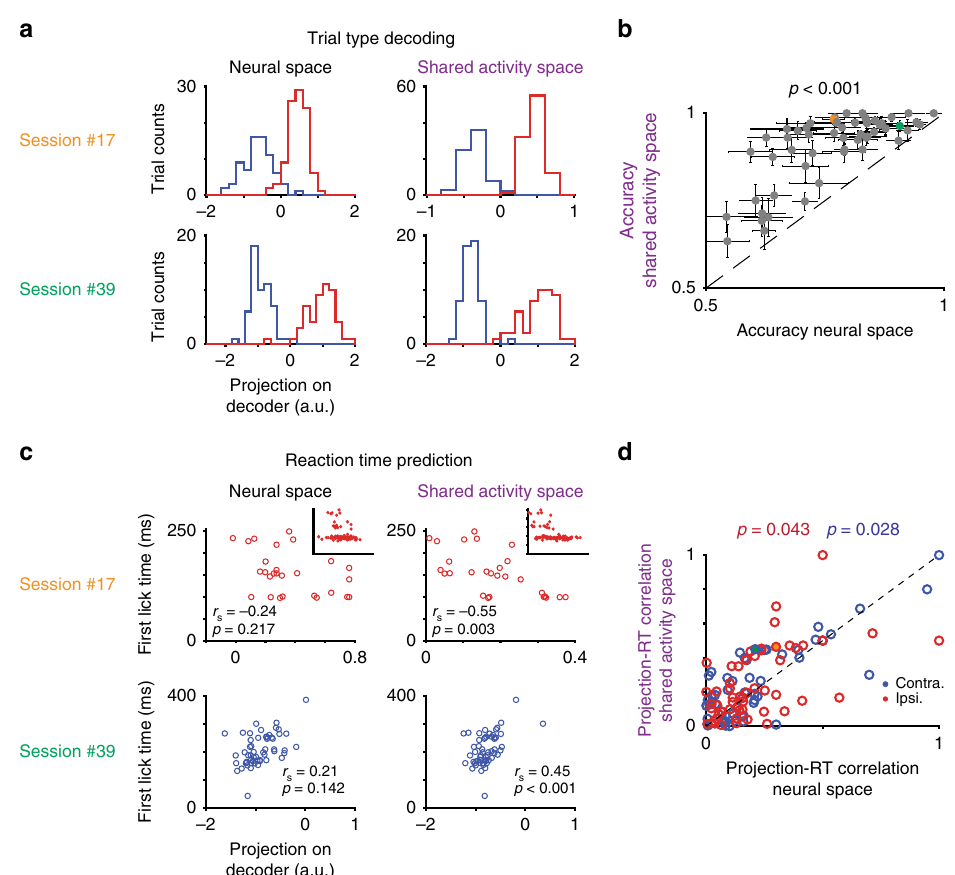
Fig. 3 Neural dynamics in shared activity space correlates with trial-by-trial variability in behavioral reaction time and performance on single trials. a Histograms of projection of all correct trials on decoder separately for each trial type (ipsi trials red, contra trials blue), for full neural space (left) and shared activity space (right). Session #17, upper; Session #39, lower. b Accuracy of decoders based on full neural space (x-axis) and shared neural space ( y -axis) across all sessions. Each circle represents a recording session. Error bar, std. across trials. Session #17, orange circle; Session #39, green circle. c Correlation between projection on decoder ( x -axis) and reaction time to the fi rst lick ( y -axis) for example session for decoder based on full neural space (left) and shared neural space (right). Top: Session #17, ipsi. trial types (blue), long reaction time trials (>100 ms), in main plot and all trials in inset. Bottom: Session #39, contra trial type (red), same convention. d Scatter across all sessions of correlation between measured and decoded reaction time. Full neural space decoder correlation ( x -axis) versus shared neural space decoder correlation ( y -axis). For each session only one trial-type is considered. Each circle represents a session. Color of circle represents trial type; p -value presents signi fi cance that correlation is strong in SAS (sign-rank test). Session #17, ipsi. trial type, orange circle; Session #39, contra. trial type, green